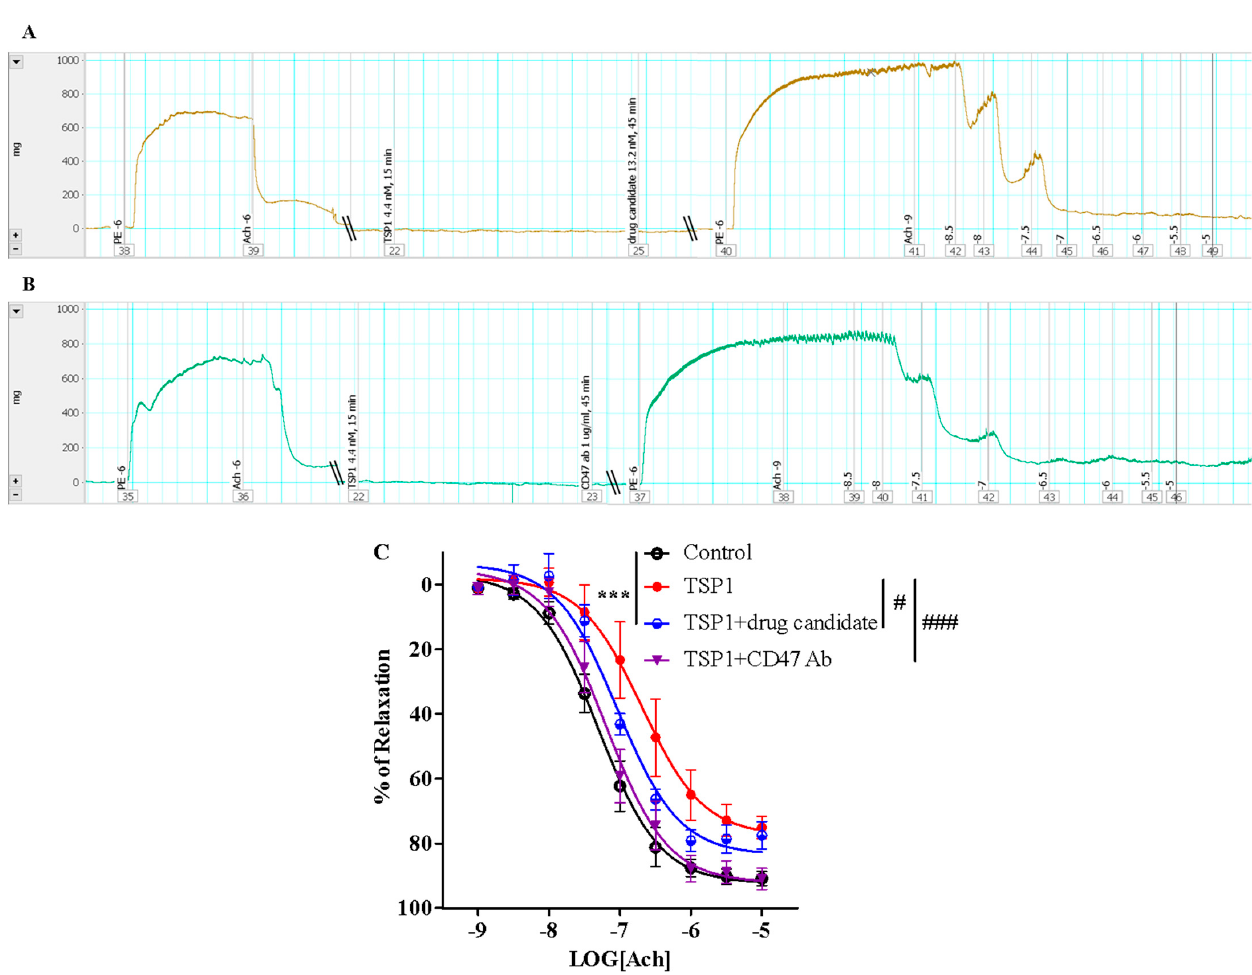
Figure 5. Acute TSP1 challenge-induced reduction in endothelium-dependent vasorelaxation was significantly restored by therapeutic treatment with the proposed CD47-based drug candidate. Representative force vs. time traces recording from endothelium intactness test to acetylcholine-induced vasorelaxation by isolated murine thoracic aorta exposed to